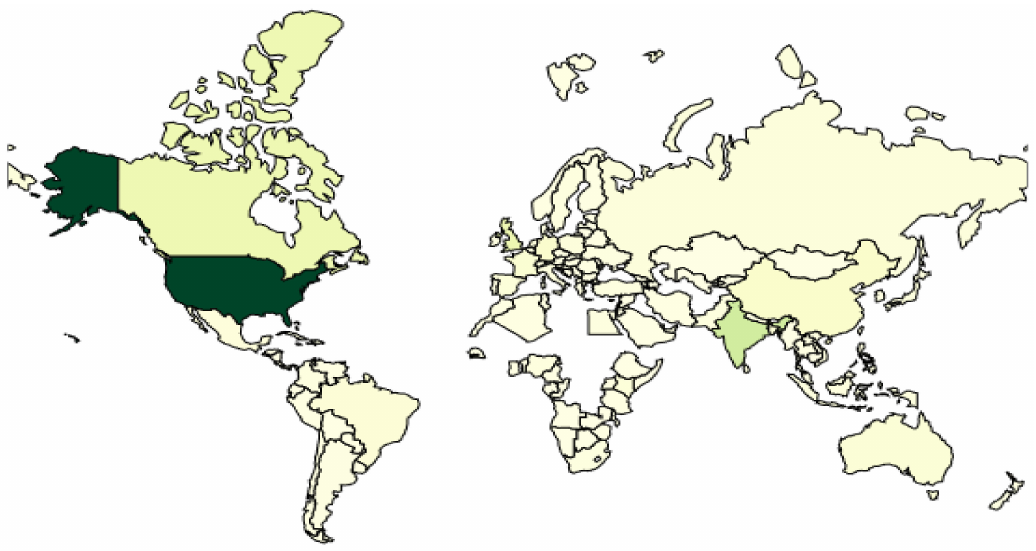
Figure 2. Geographic visualization of GitHub repositories by